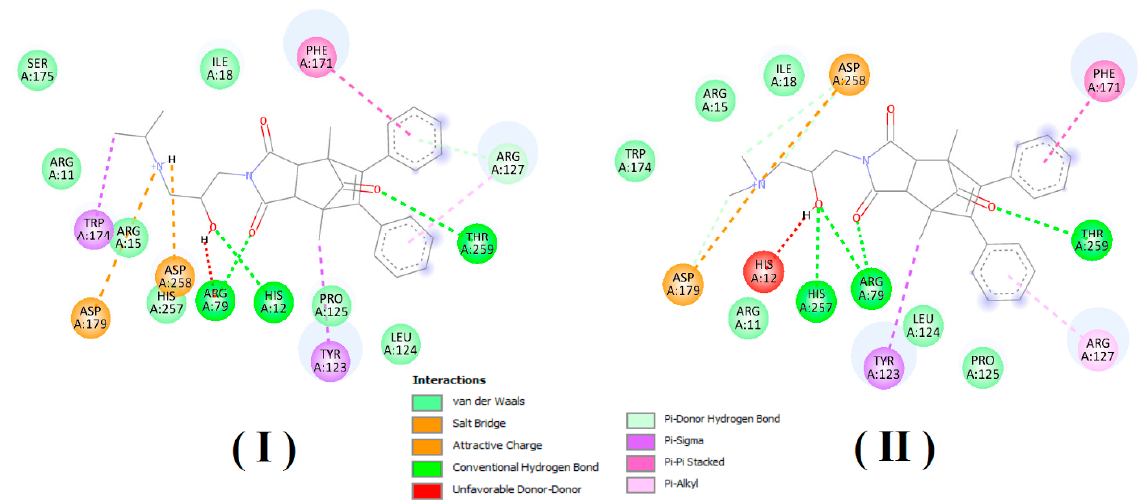
Figure 6. Structure of the active site of prostatic acid phosphatase and potential types of interactions between the competitive inhibitor ( I ) and ( II ) and amino acids present in the active site of the enzyme.